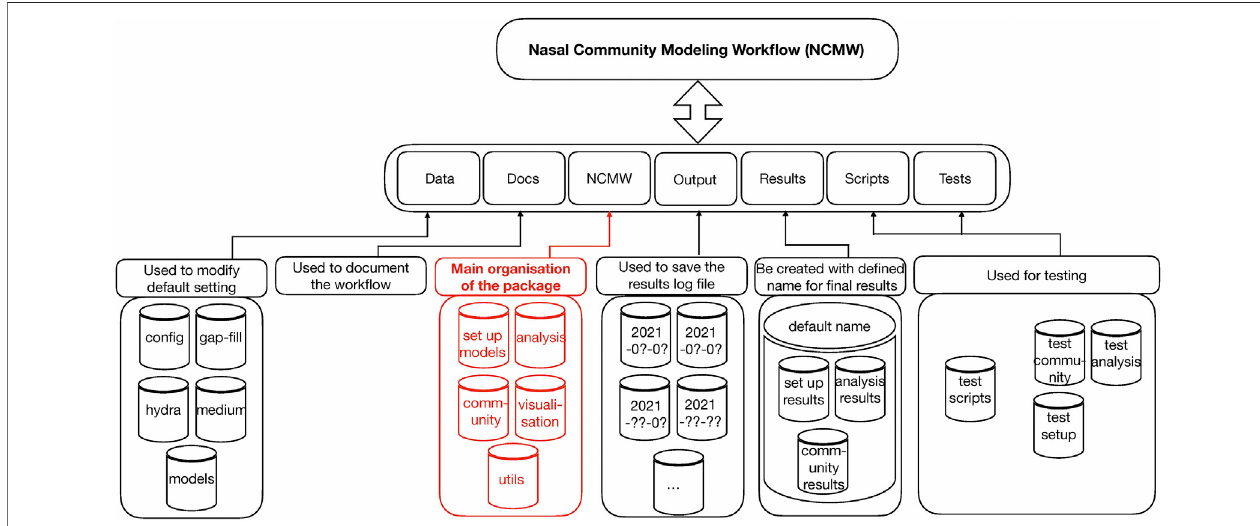
FIGURE 1 | Entire nasal community modeling work fl ow (NCMW). In the fi rst layer, the package includes seven folders. In the second layer, the tasks which each folder can do are represented. In the last layer, the sub-folders included in each folder are shown. The highlighted part, as the red part, is the main folder ofthe package. To run the package and get the results, we use command ncmw setup, ncmw analysis, and ncmw community in the command line.